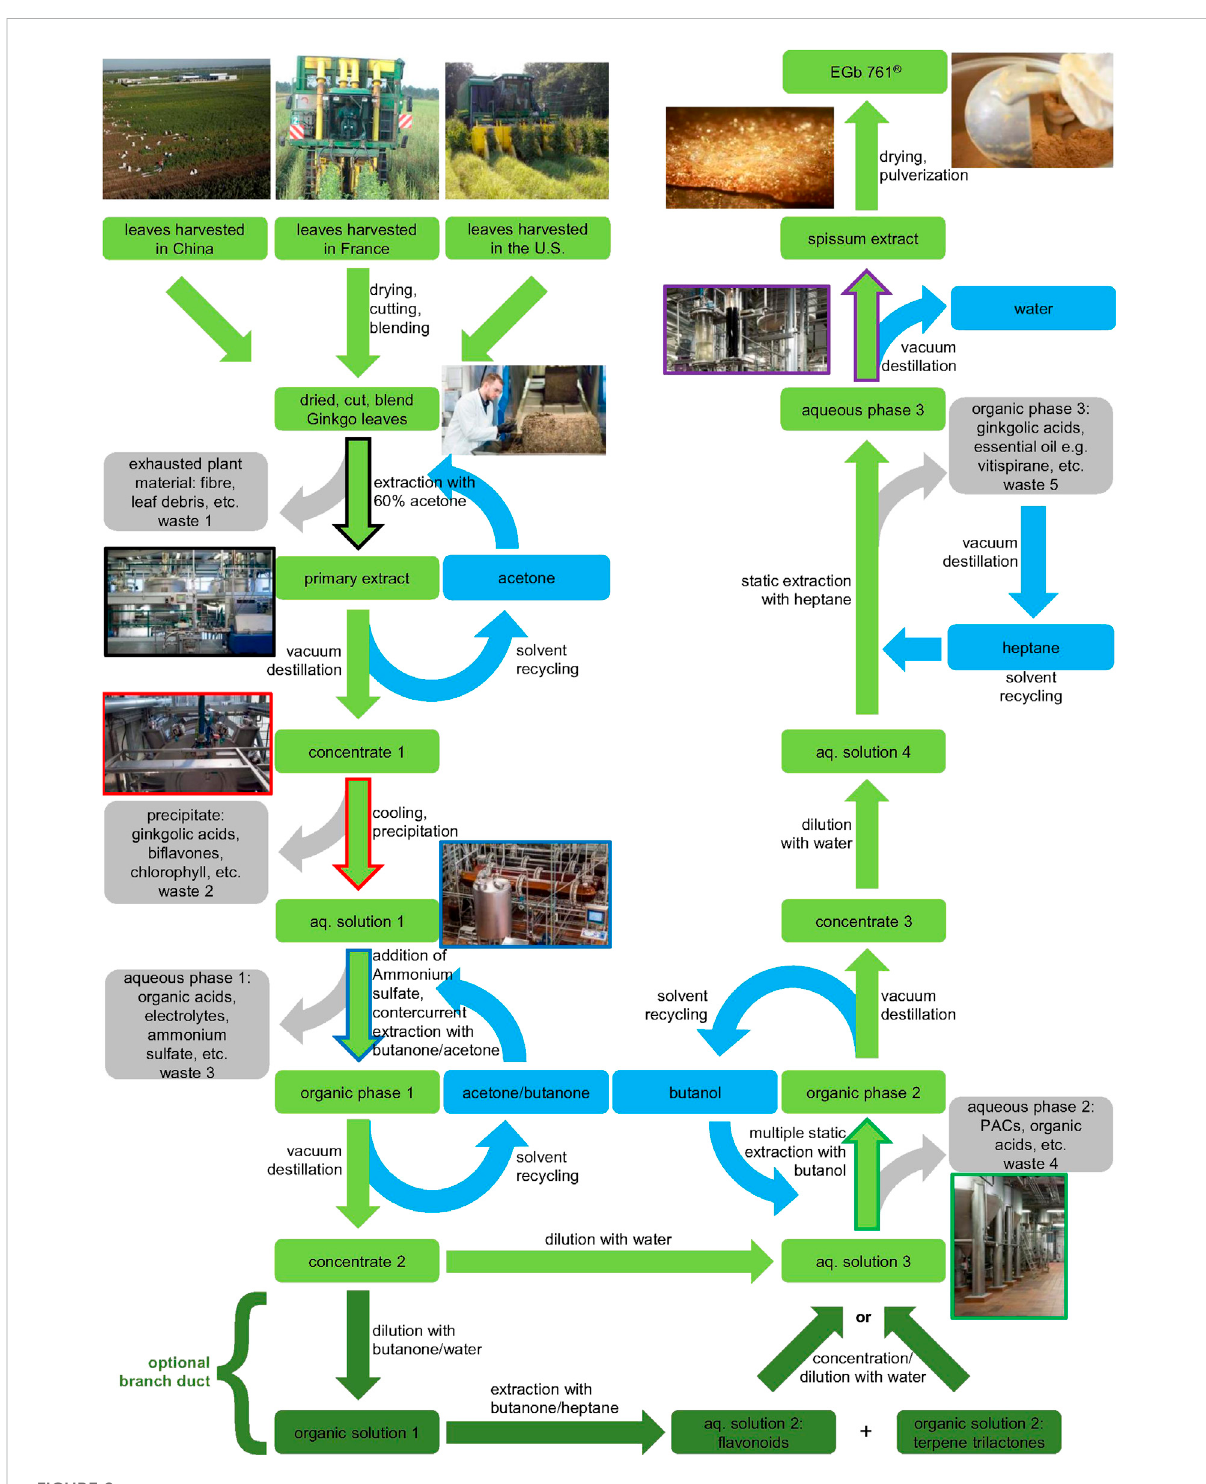
FIGURE 2 Scheme of the EGb 761 ® multistep production process. Color coding: green – value phase, olive-green – optional branch duct, gray – waste phase, blue – solvents, fringe colors indicate the corresponding process facility units. The process isvastly different from otherproduction processes (see Figure